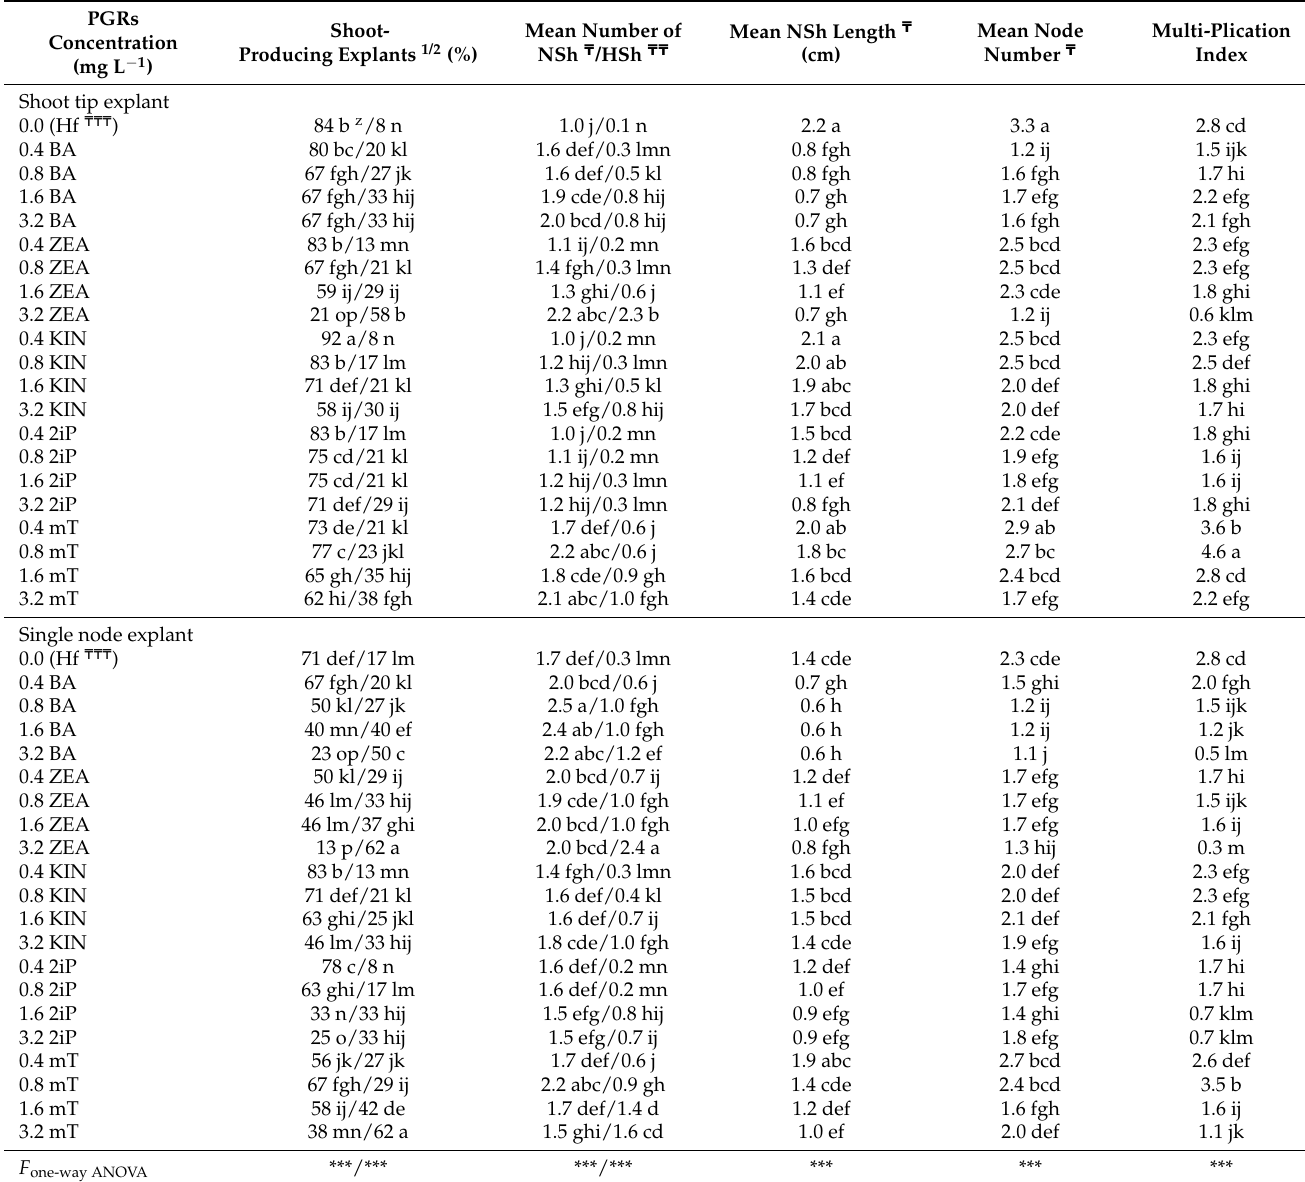
Table 1. Effect of Salvia species and explant type on axillary shoot production of explants excised from in vitro seedlings of Greek sage species, at the establishment stage of in vitro cultures on a hormone-free MS medium.